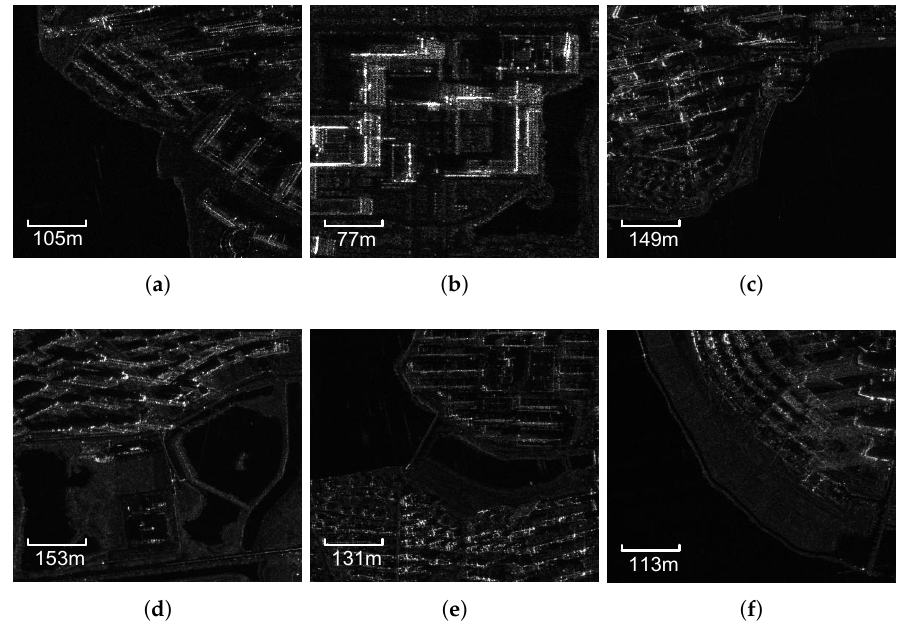
Figure 3. The original GF-3 image scenes. ( a ) HH; area: 0.25 km 2 . ( b ) VV; area: 0.14 km 2 . ( c ) HH; area: 0.50 km 2 . ( d ) VV; area: 0.53 km 2 . ( e ) HH; area: 0.39 km 2 . ( f ) HH; area: 0.29 km 2